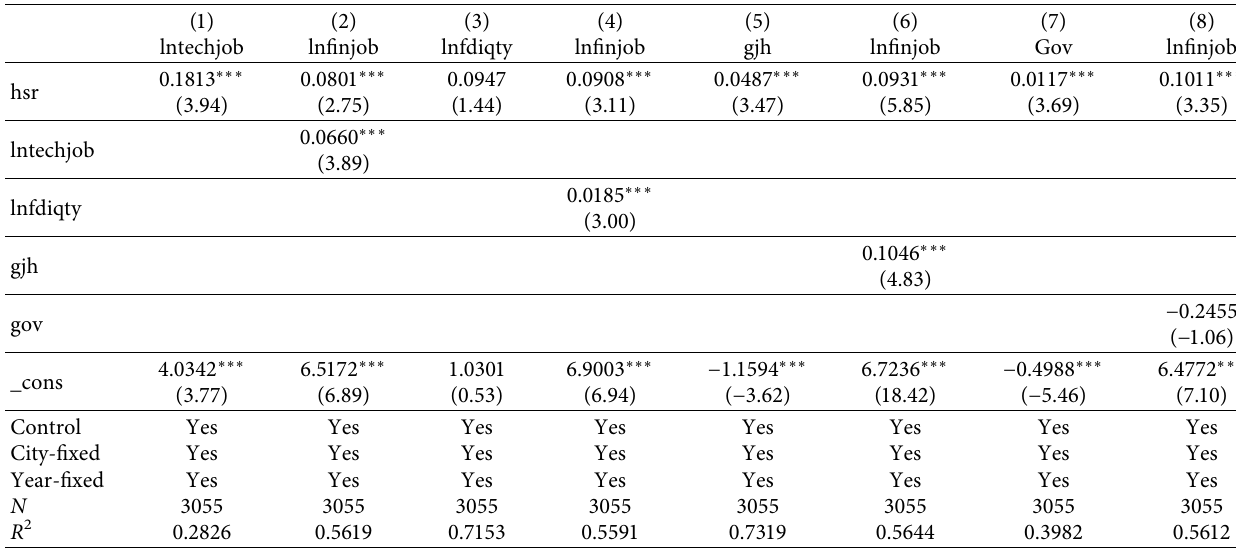
Table 5: Intermediary effect